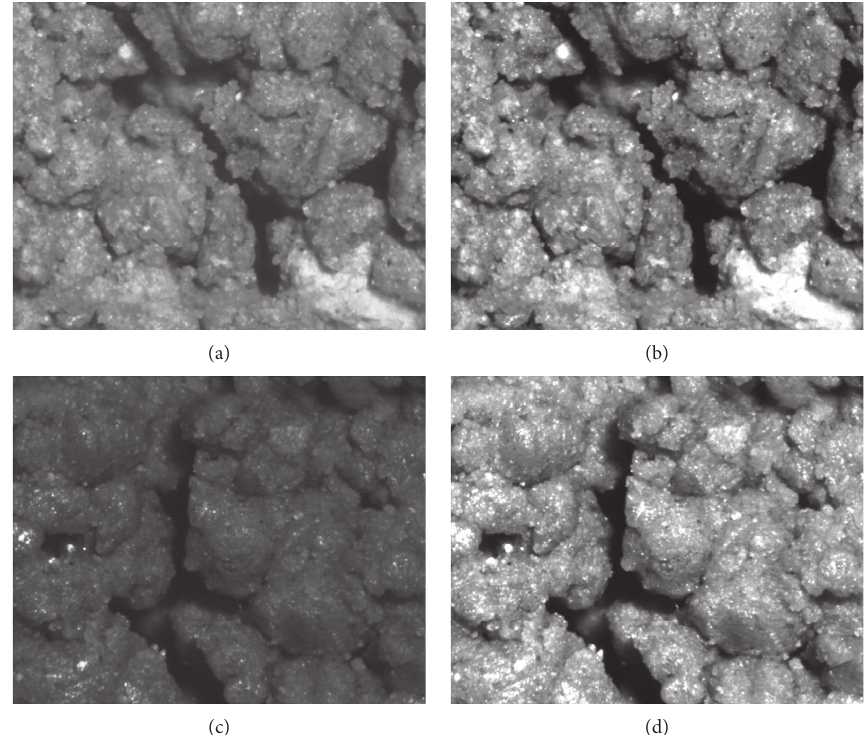
Figure 4: Two examples with image enhancement: (a) initial image 1; (b) enhanced image 1; (c) initial image 2; (d) enhanced image 2.